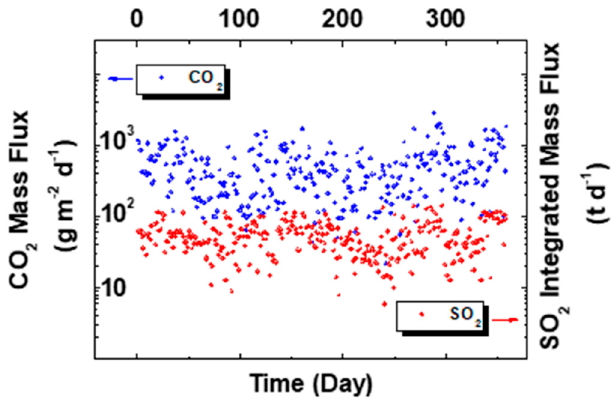
Figure 7. ( a ) SO 2 flux; ( b ) CO 2 flux; ( c ) VLP time series extracted from LGS bulletins in 2019–2021. The observable quantities, i.e., SO 2 integrated mass flux and CO 2 mass flux, repre- sented in the graph show a coherent behavior over time (Figure 8).